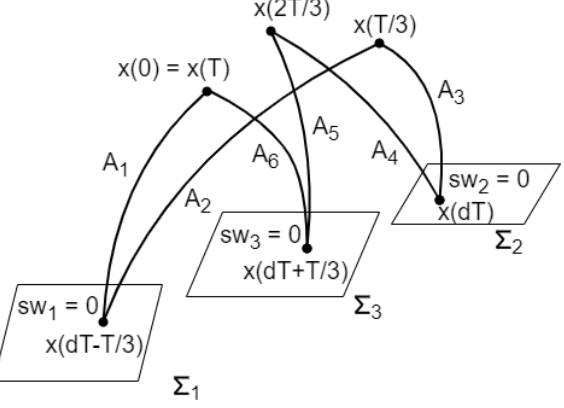
Figure 3. One cycle of orbit evolution of state variables x ( t ) .